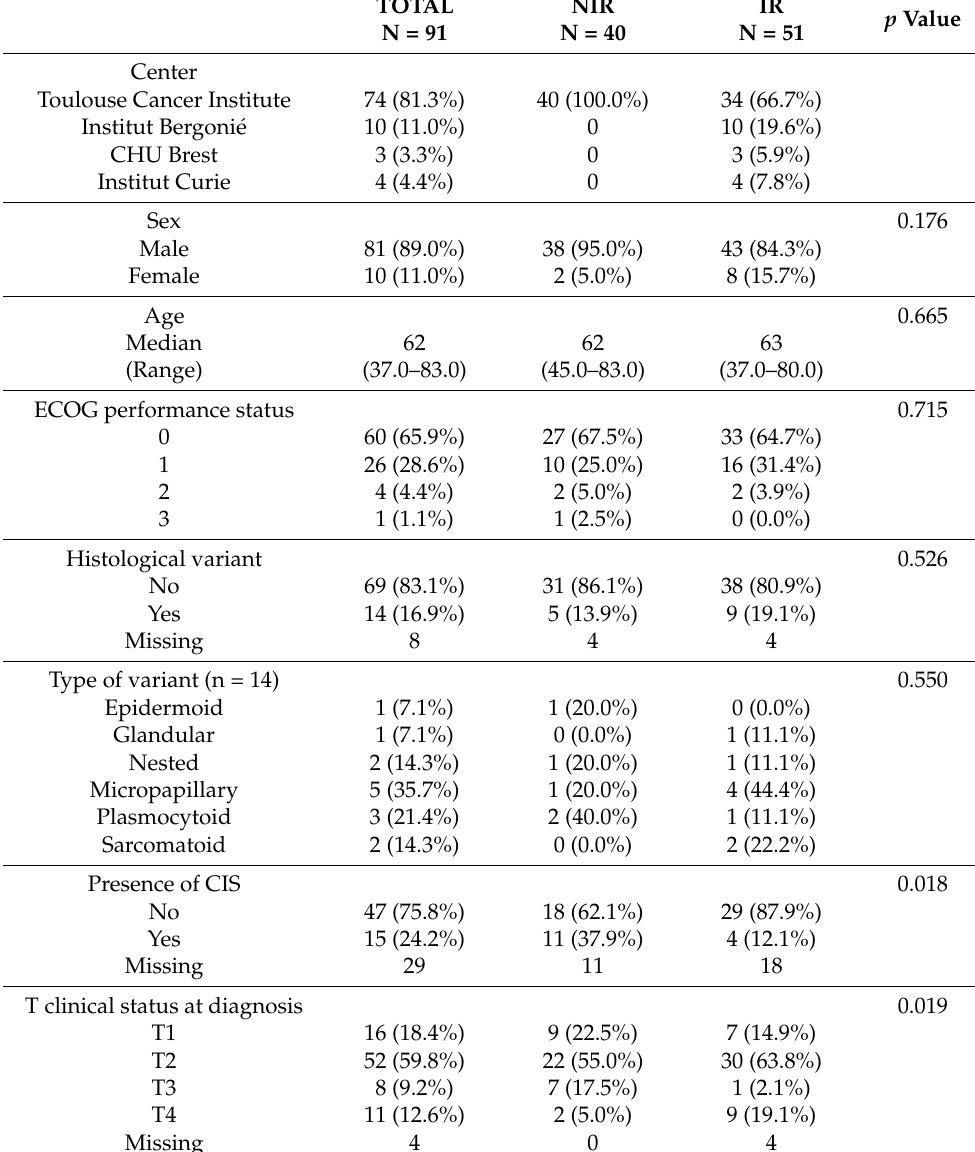
Table 1. Patient